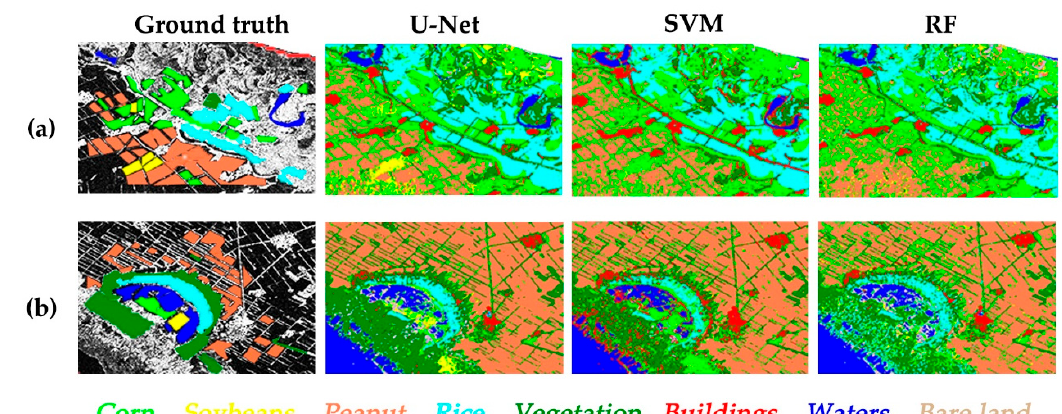
Figure 11. Crop mapping results of U-Net, SVM, and RF in areas with complex planting structures.